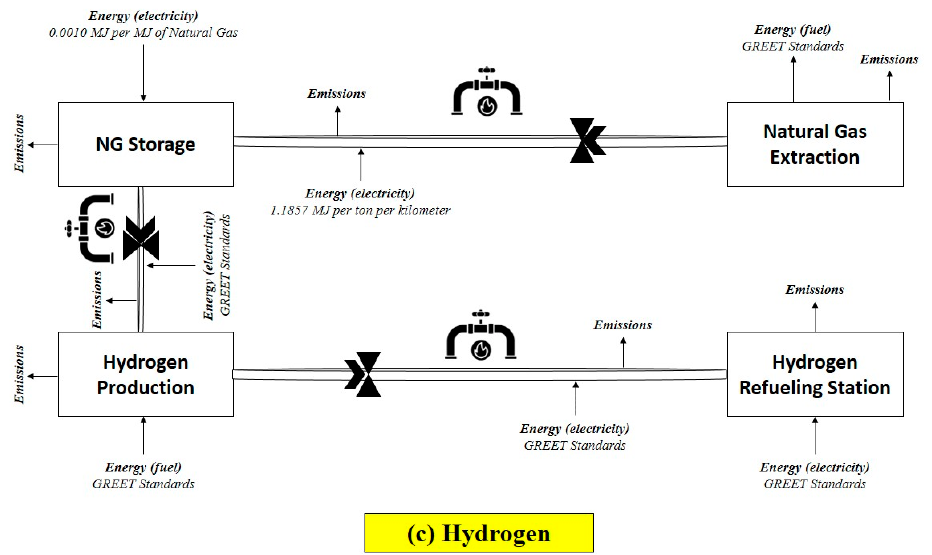
Figure 4. Moroccan Energy Profile and Pathways.